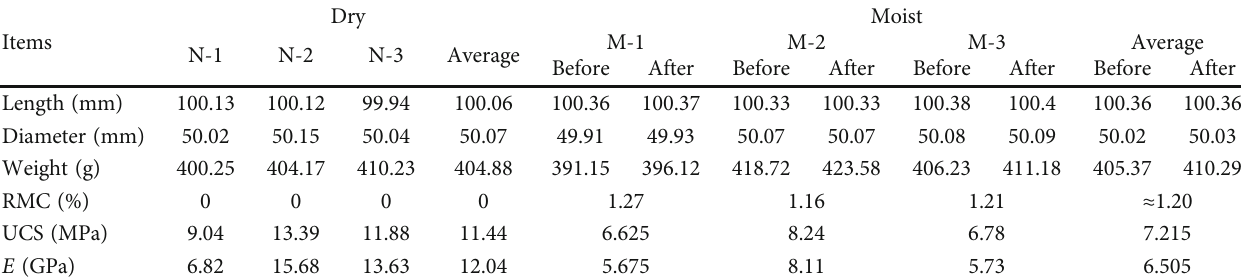
Table 1: Basic test information of mudstone specimen before and after humidi fi cation curing.